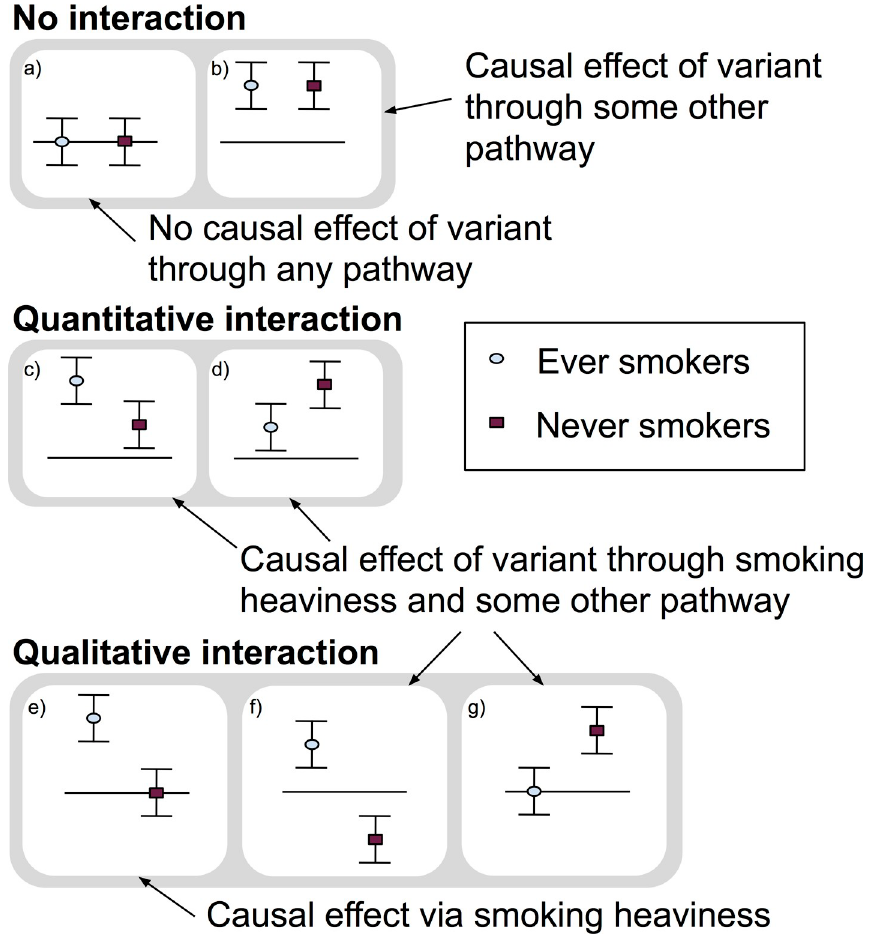
Fig 1. Illustration of possible GxE MR results and their interpretation. This figure illustrates the three broad types of results of a GxE study on smoking heaviness: 1) no interaction between ever and never smokers, 2) a quantitative interaction, where associations are in a consistent direction but one is stronger than the other, or 3) a qualitative interaction, where the effect only occurs in one group or the estimates are in opposite directions, also known as a cross over effect [22]. Both qualitative and quantitative interactions can provide evidence of a causal effect of the genetic variant via smoking heaviness. However, when an effect exists in never smokers the estimate in ever smokers may be comprised of both an effect of the genetic variant through smoking heaviness and an effect through another